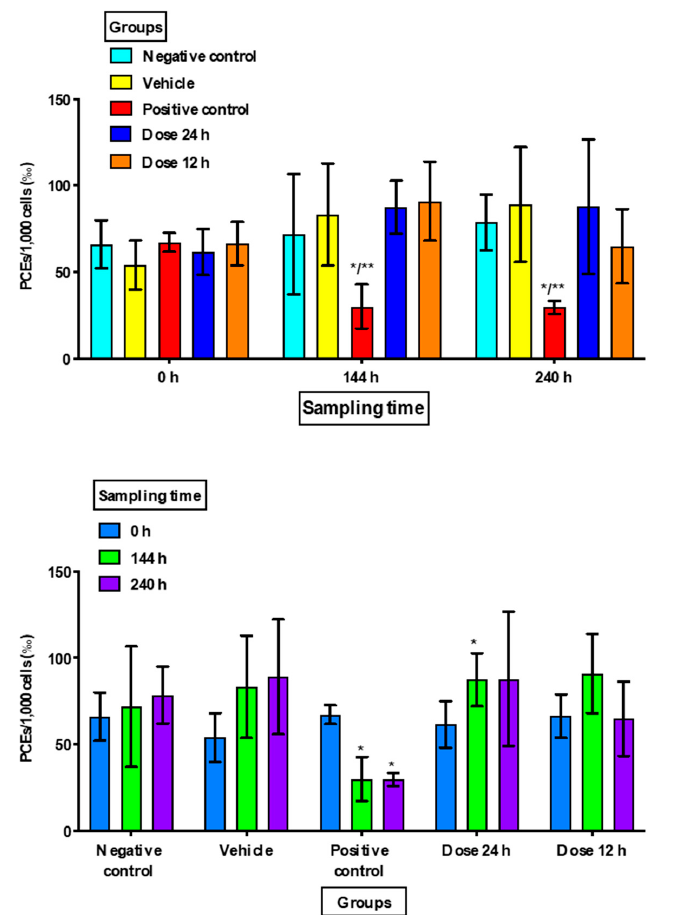
Figure 3. Frequency of polychromatic erythrocytes (PCEs) in the study groups at the different sampling times. Frequency values are expressed as the mean ± standard deviation in 1000 cells (‰). h: hours; NS: not significant. Intergroup comparisons were between the study groups: * versus negative control and ** versus vehicle. Intragroup comparisons were made between the * basal value (0 h) and sampling times (144 and 240